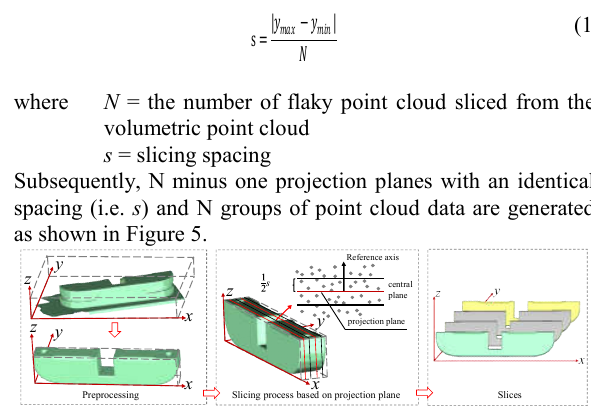
Figure 5. Schematic diagram of the slicing algorithm based on point cloud.